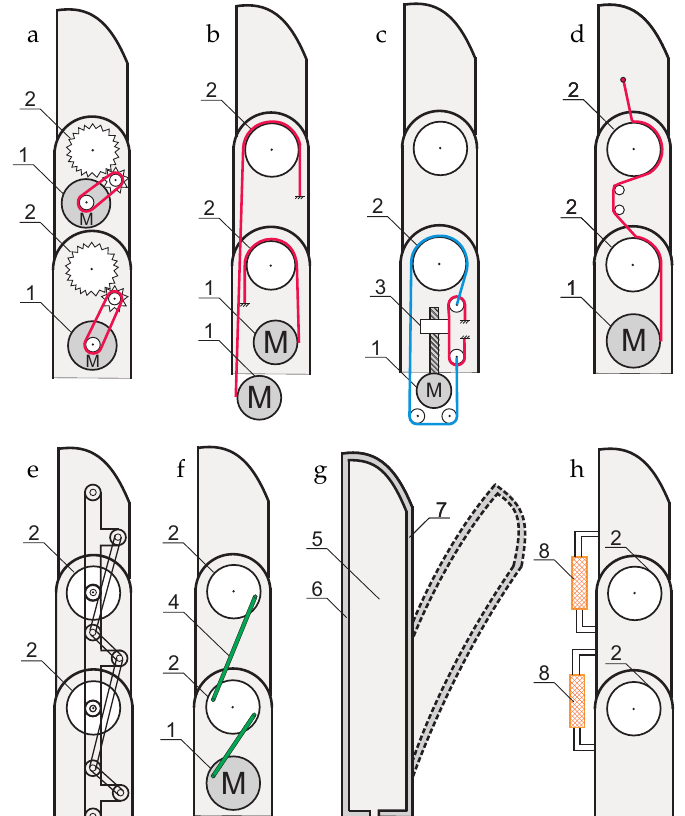
Figure 2. Joint drive mechanisms for robotic fingers: direct drive with gears ( a ), fully actuated joints with tendons ( b ), backdrivable tendon ( c ), underactuated finger with tendon (red or blue) ( d ), rigid linkage system ( e ), underactuated joints with rods (green) ( f ), pneumatically actuated ( g ), pneumatic/hydraulic muscles ( h ). Legend: 1—electrical motor, 2—joint, 3—nut, 4—rod, 5—air chamber, 6—elastic fabric, 7—inelastic fabric, 8—pneumatic/hydraulic muscles. Table 1. Related work—joint drive mechanisms review. Tendon